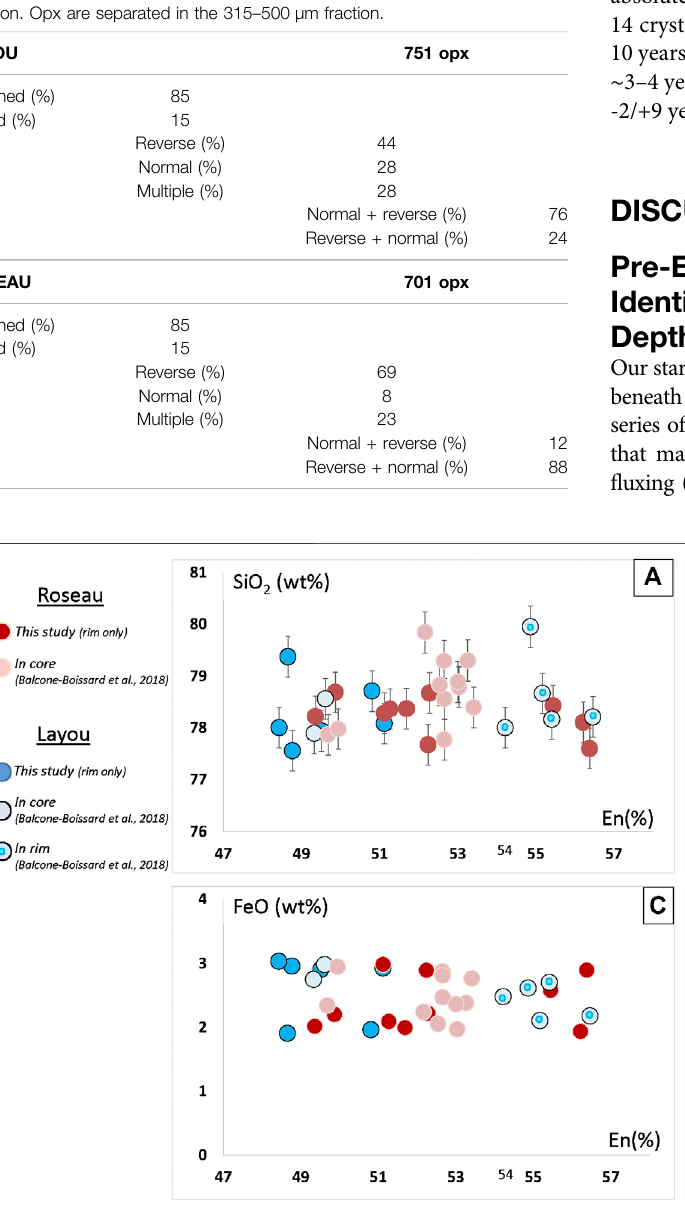
Frontiers in Earth Science |